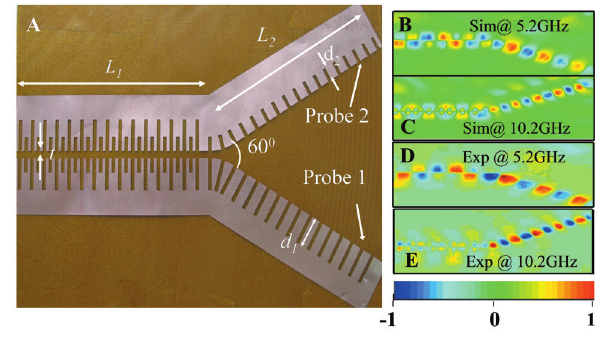
Figure 6: (A) Photo of the fabricated planar frequency splitter, which is composed of a straight composite periodic grating and two single-periodic grating branches, where L = 11 mm, and d = 5 mm. (B–E) Simulated and measured E d 1 2 distributions of the frequency splitter at 5.2 GHz and 10.2 GHz. Reproduced from [42] with